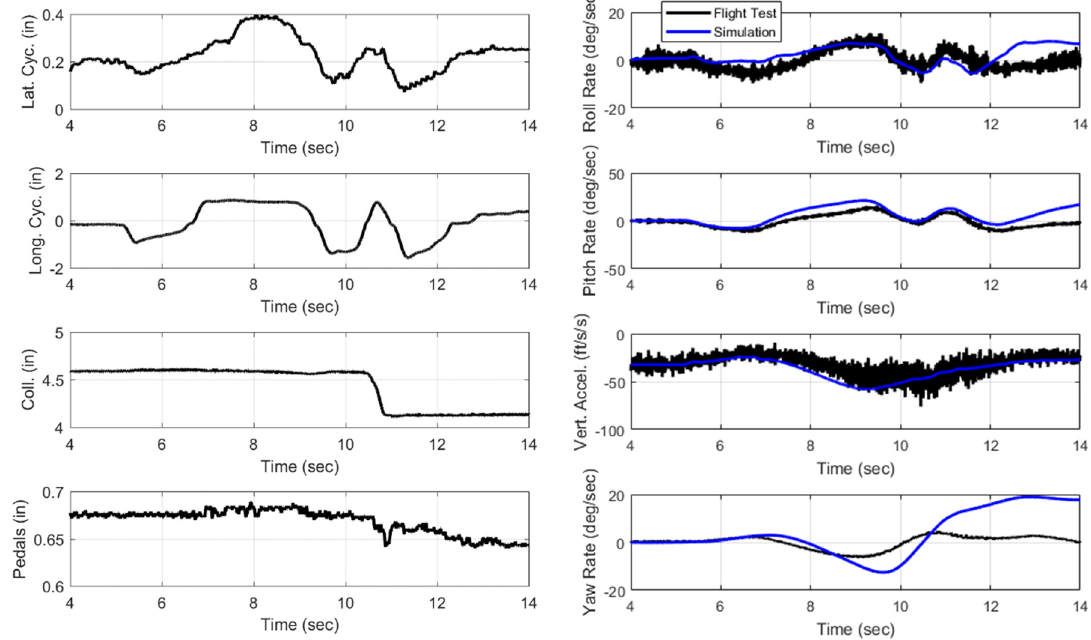
Figure 5. Sample time domain response of 2-3-1-1 longitudinal input from flight test [19] and the simulation model at 80 kts forward airspeed.